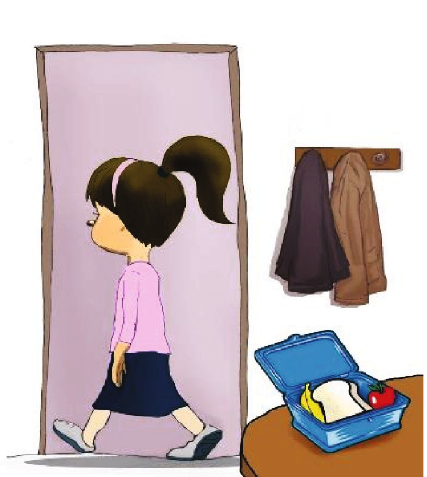
Figure 2: “ Dina forgets her food.